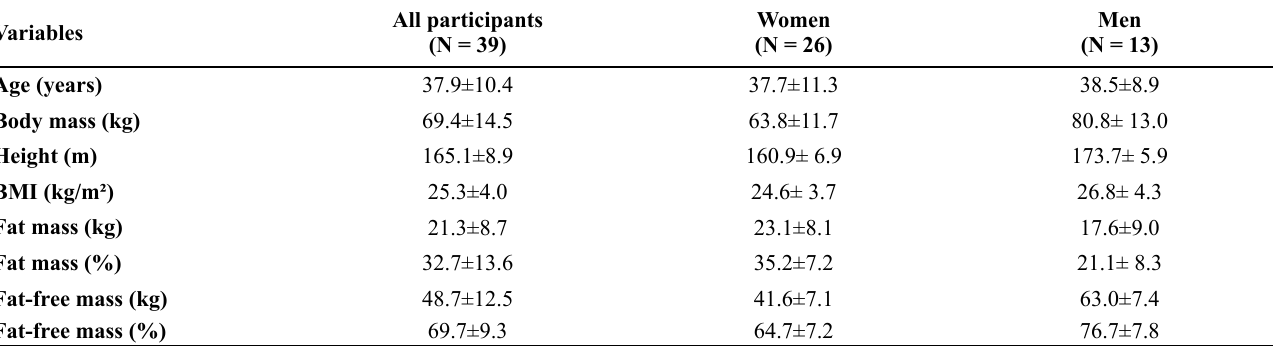
Table 1 . Age, anthropometric, and body composition parameters of physically active men and women.